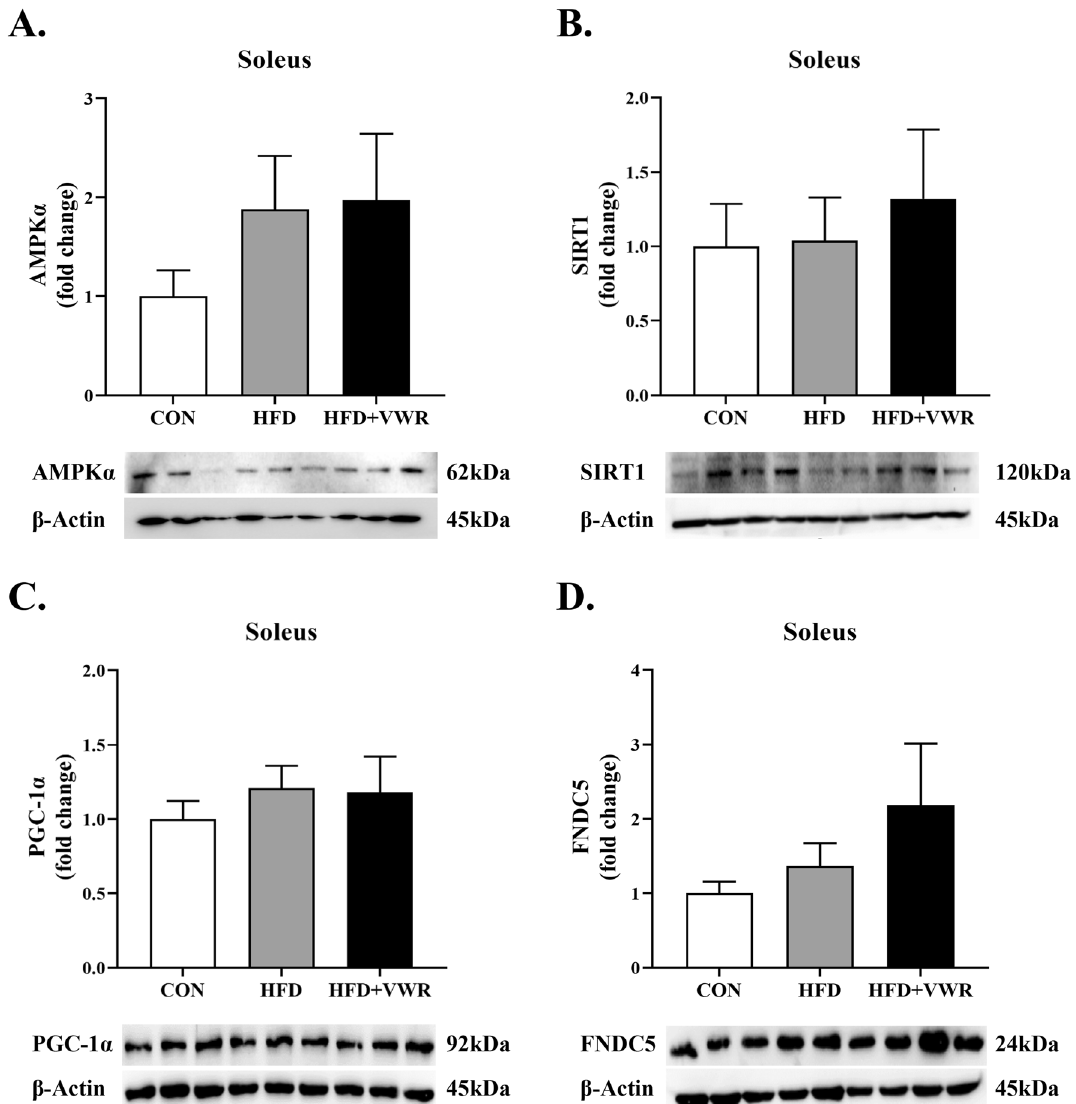
Fig. 3 Effects of HFD and VWR exercise on AMPKα A , SIRT1 B , PGC-1α C , and FNDC5 D in the soleus muscles. Values are shown as mean